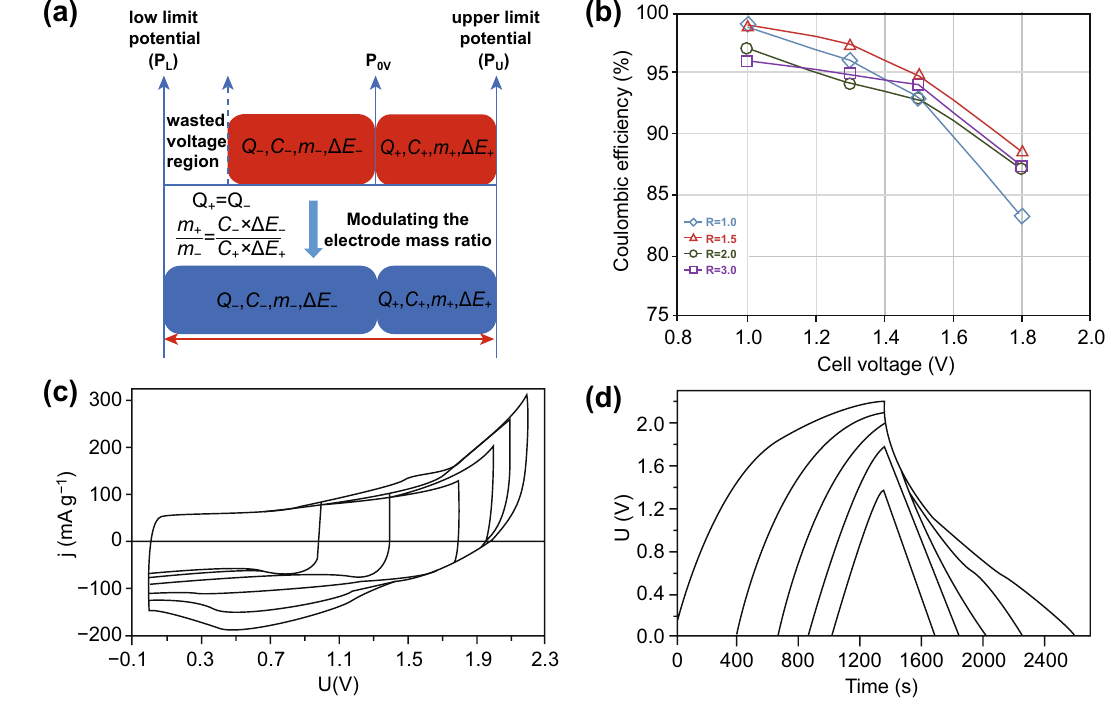
Fig. 3 a Mechanism illustration showing the strategy to increase the cell voltage of aqueous SCs through modulating the electrode mass ratio. b Function relationship between coulombic efficiency and operating voltage for the carbon xerogel‑based asymmetric systems with different elec‑ trode mass ratios. Adapted with permission from Ref. [55]. c CV curves of MnO 2 //AC device operating in 0.5 M Na 2 SO 4 with mass ratios of 2.5 at scan rate of 2 mV s −1 . d Galvanostatic charge/discharge curves of MnO 2 //AC device for mass ratio of 2.5. Adapted with permission from